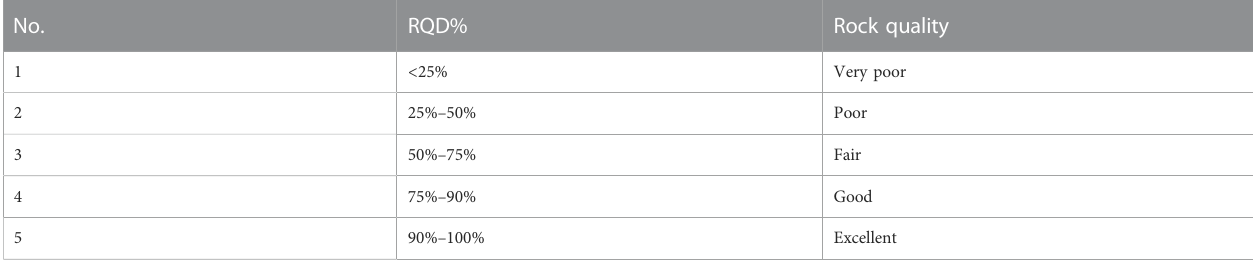
TABLE 1 Correlation between RQD and rock mass quality. No.